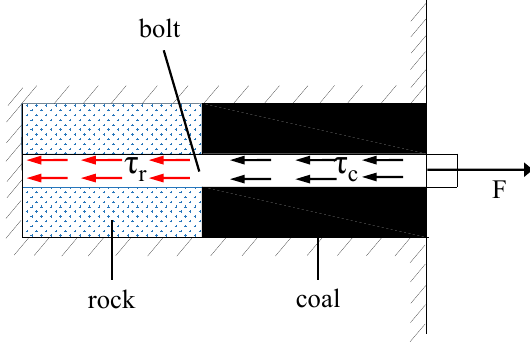
Figure 12. Stress diagram of the bolt during the pull-out test.